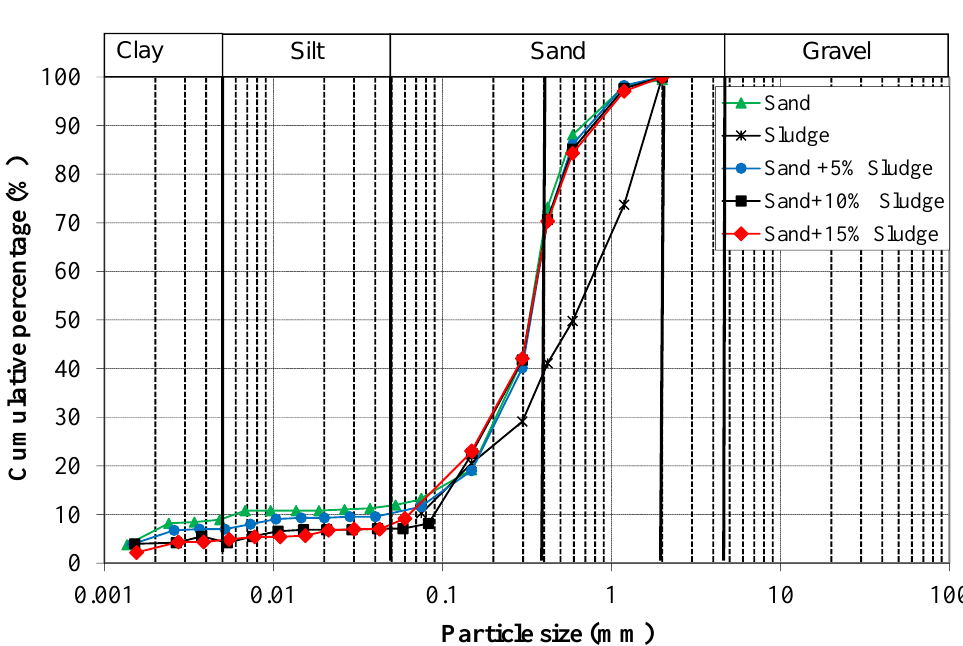
Figure 4. Particle soil distribution, sewage sludge, and different soil – sludge mixtures analyzed.